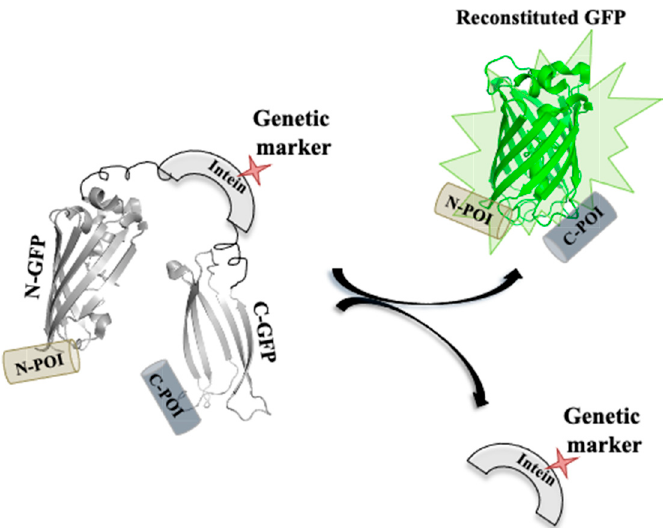
Figure 10. Schematic representation of intein use as a genetically selectable marker. The intein sequence is interrupted by selectable markers. In a suitable genetic background, the intein excises out resulting in the expression of reconstituted green fluorescent protein (GFP) fused with extein fragments on either side. POI is protein of interest.